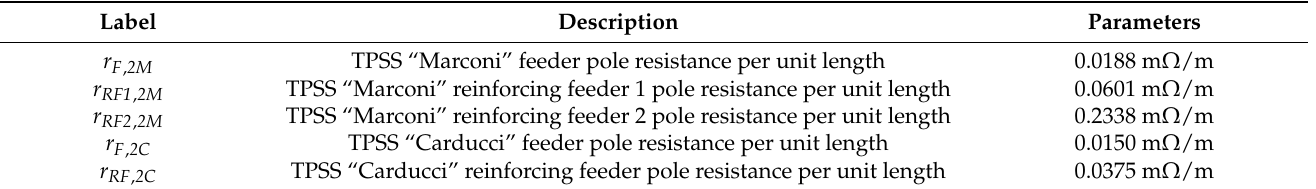
Table 5 gathers the resistive parameters of the FS 2 feeding cable system. Table 5. Feeding cable resistance per unit length of FS 2.